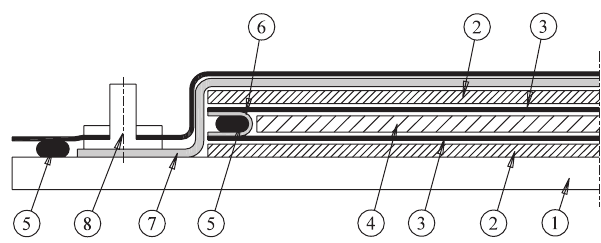
Figure 3: Cross section of vacuum-bagged laminate: 1. Steel tool plate (12.7 mm). 2. Stainless steel plate (0.744 mm). 3. Bagging film (Thermalimide, Airtech) coated with release agent (Frekote ® 44-NC™, Henkel). 4. Tack-welded laminate. 5. High-temperature sealant tape (SM-5160 TACKY-TAPE ® , Schnee-Morehead) 6. 6 oz. plain woven fiber- glass cloth. 7. Breather (Airweave ® UHT 800, Airtech). 8. Vacuum valve